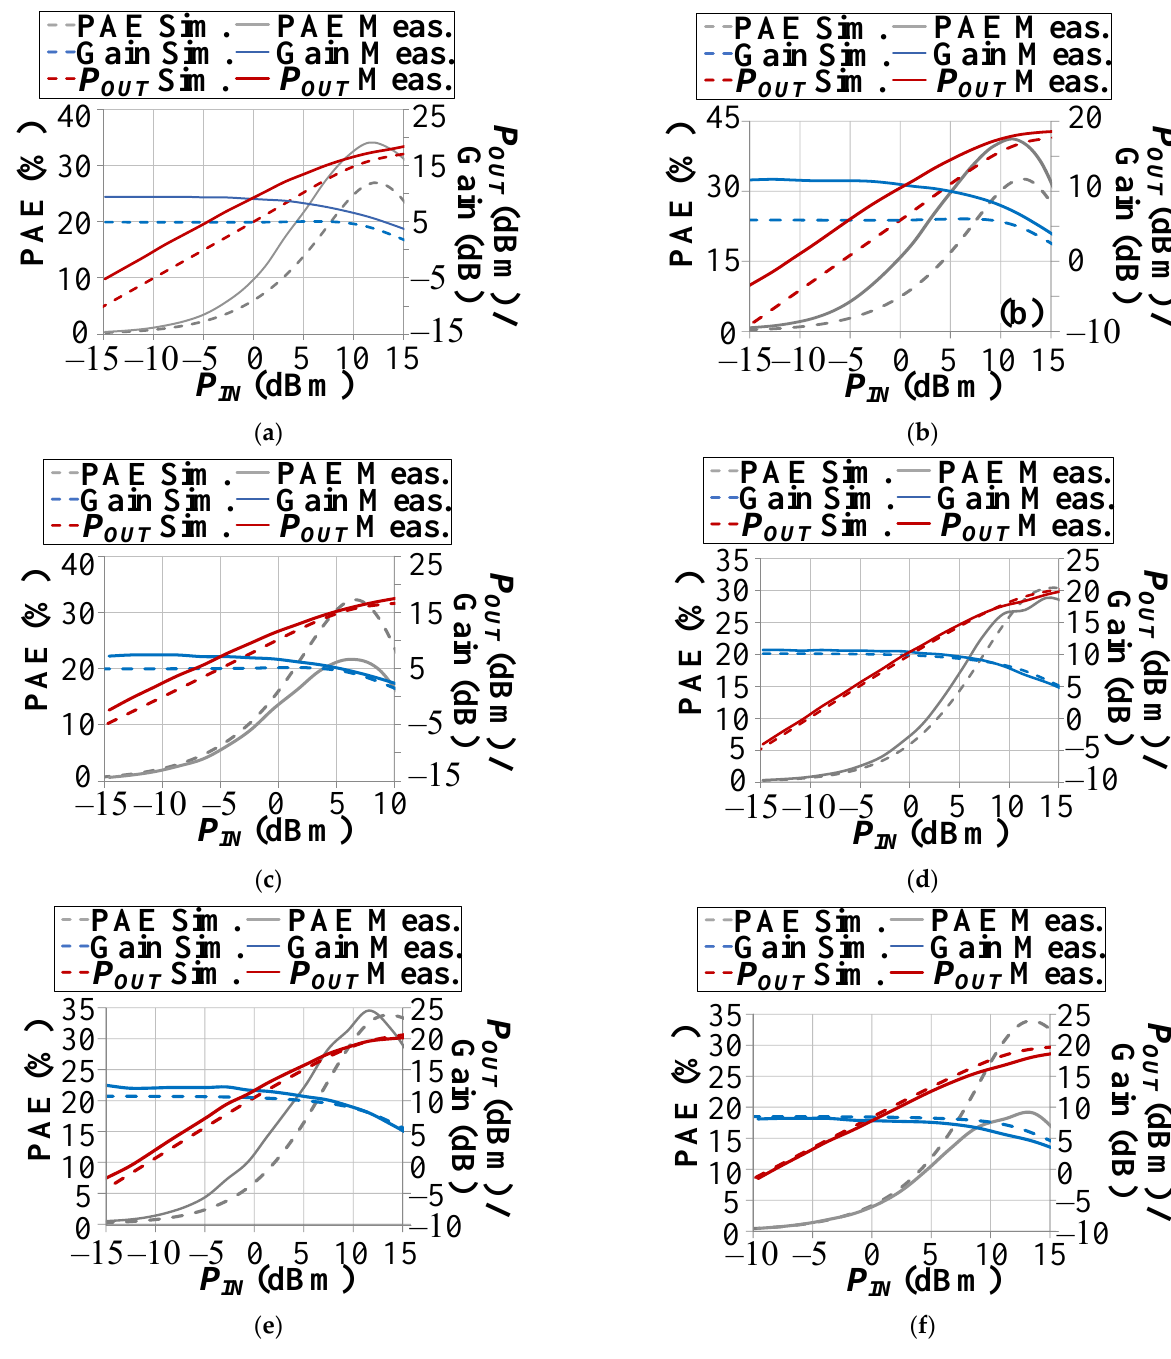
Figure 5. Large-signal EM PEX simulation vs. CW measurement of the broadband single-ended GaN PA with V DD = 4 V at ( a ) 24, ( b ) 28, and ( c ) 44 GHz and V DD = 6 V at ( d ) 24, ( e ) 28, and ( f ) 44 GHz.